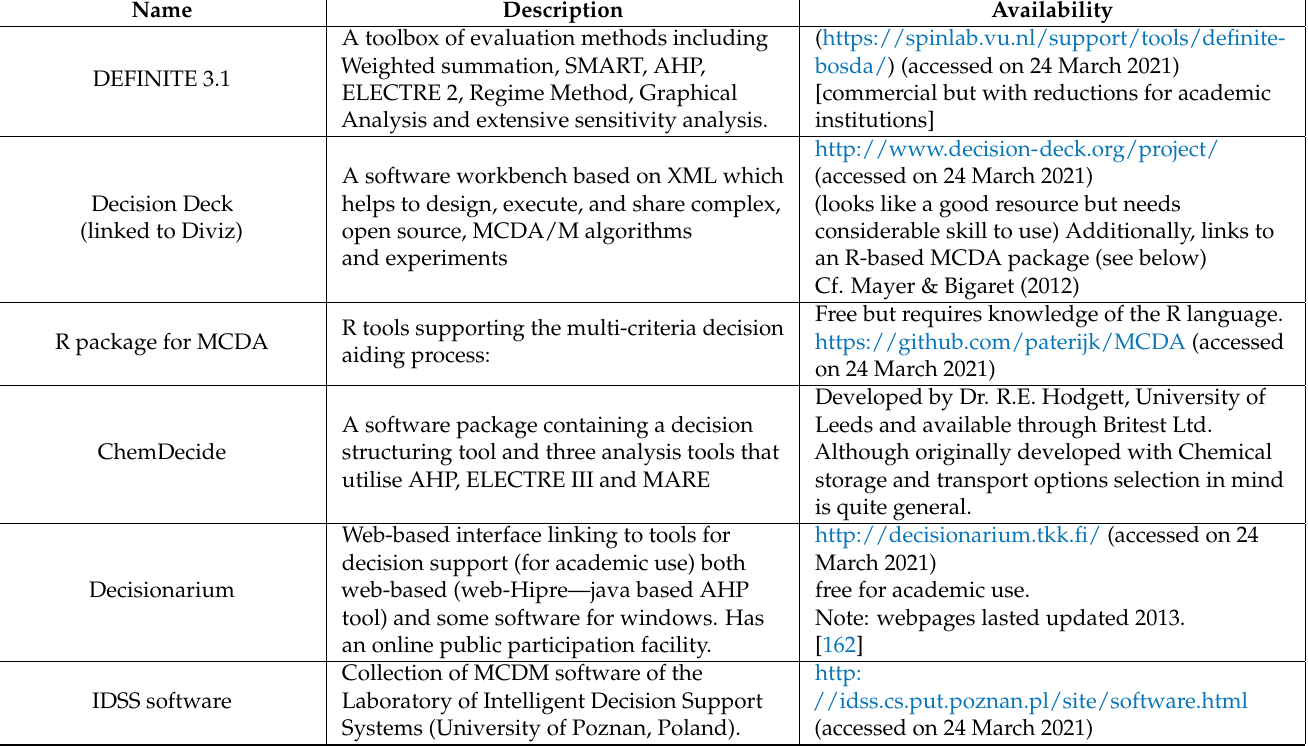
Table 14. MCDA Toolboxes of